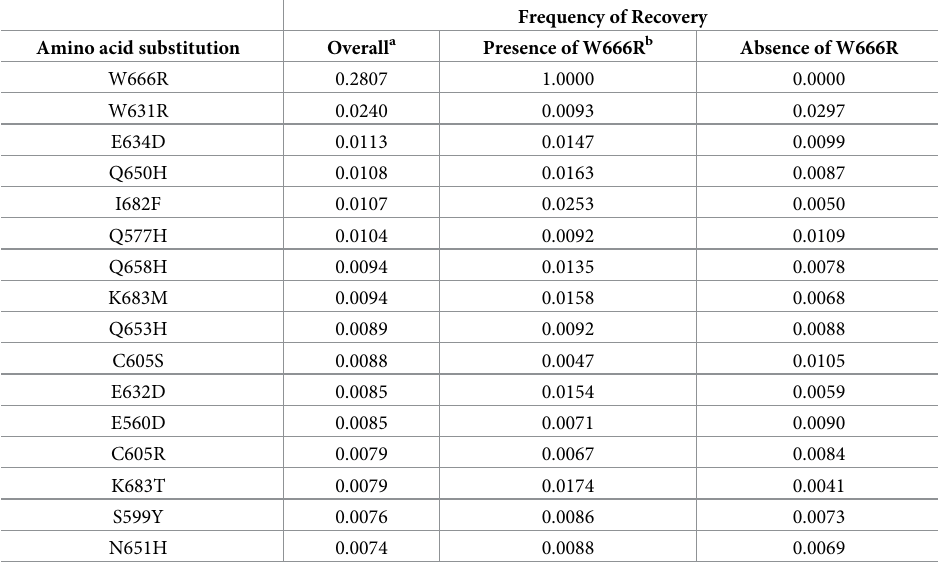
Table 5. Mutations recovered in NGS analysis of screen for binding to 10E8